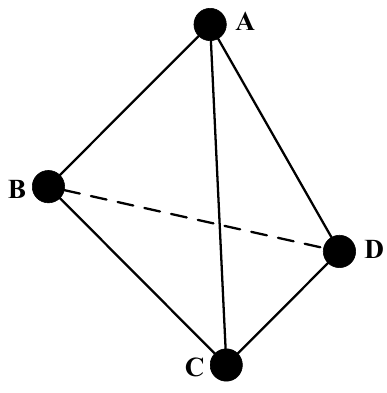
Figure 2. A simple void model.